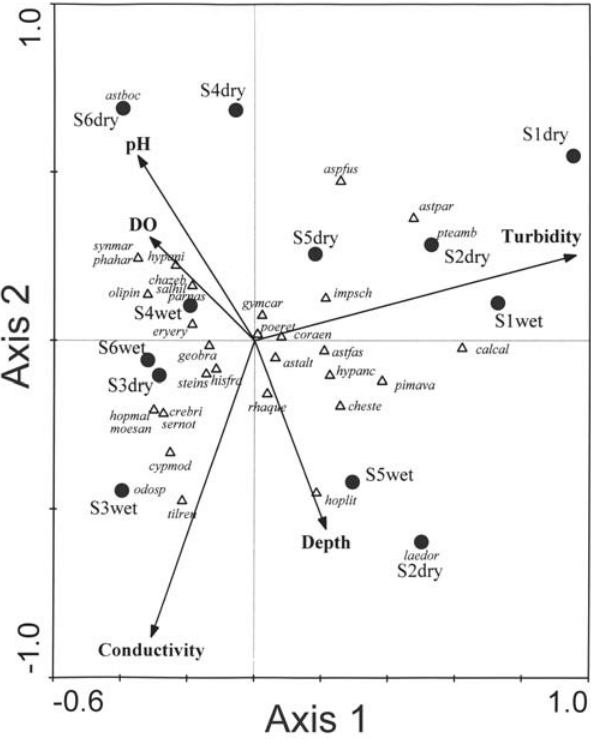
Fig. 3. Representation the two first axis of the Canonical Cor- respondence Analysis, showing the sampled stretches (la- belled S1-S6) in the dry and wet periods (circles), species (triangles), and environmental descriptors (arrows). The eigenvalue of axis 1 and axis 2 are 0.26 and 0.16, respectively, displaying 38% of the total inertia (= weighted variance) in the abundances and 68.8% of the variance in the weighted averages and class total of species with respect to the envi- ronmental variables. Monte Carlo significance test (4.999 per- mutations) under the full model option indicate that canoni- cal axes are marginally significant (“F-ratio” = 1.509, P-value = 0.09). To species codes see Table